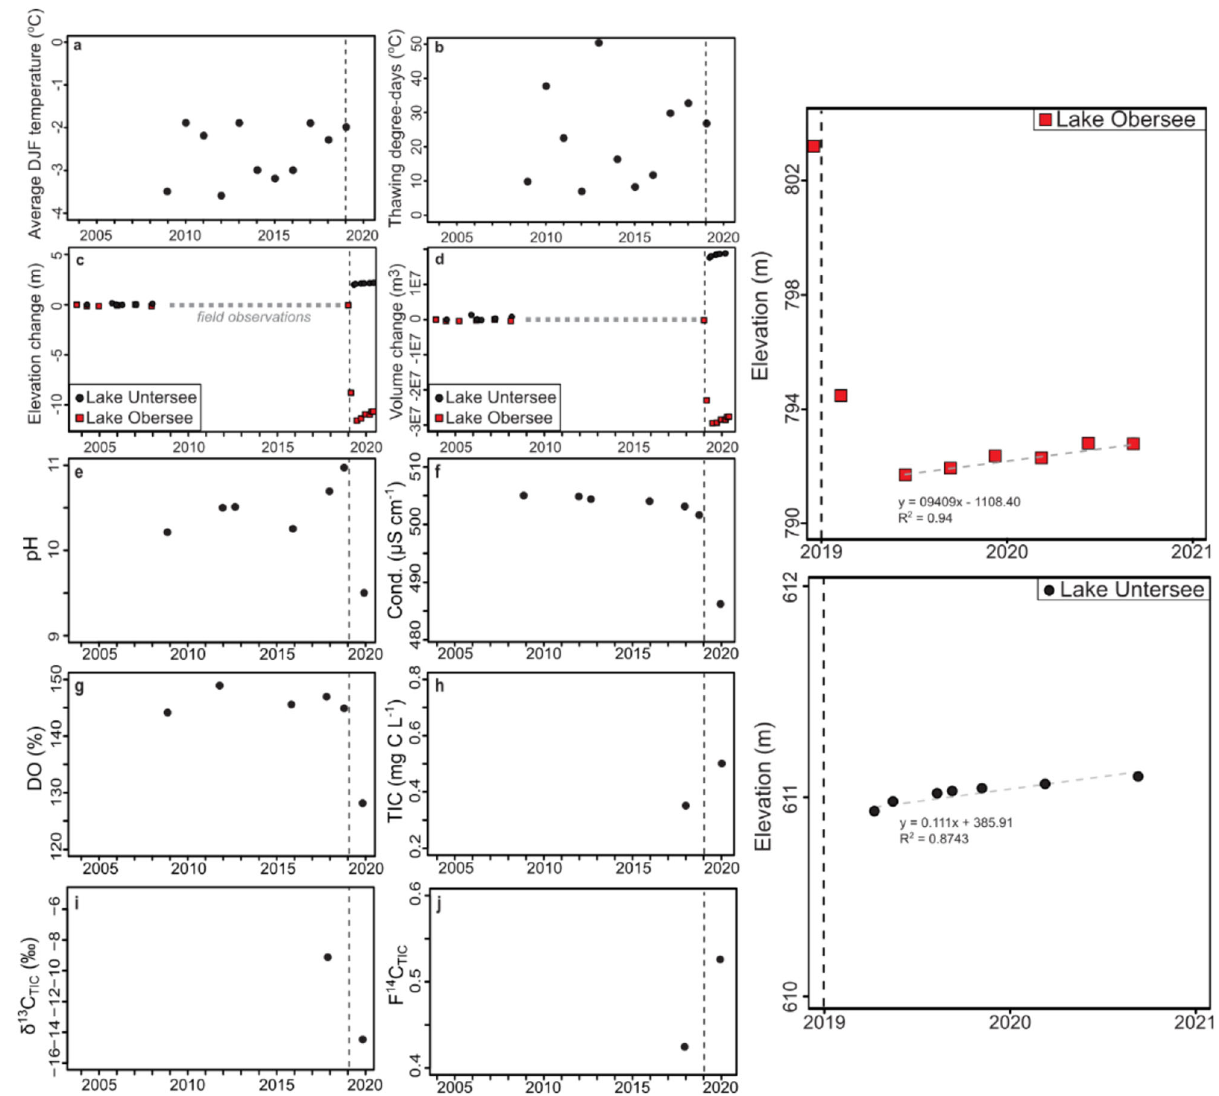
Fig. 3 2004 – 2020 Variations in hydrochemical parameters of Lake Untersee, Antarctica. a Average summer (December, January, and February; DJF) air temperature (°C) at Lake Untersee. b Thawing degree days at Lake Untersee (°C). c , d Changes in elevation (m) and volume (m 3 ) for lakes Untersee and Obersee (elevation data from ICESat and ICESat-2). e – j Mean values of pH, conductivity ( µ S/cm − 1 ), dissolved oxygen (DO%), total inorganic carbon (TIC; mg C L − 1 ), δ 13 C TIC ( ‰ ), and F 14 C TIC in the oxic water column of Lake Untersee. The dashed vertical line represents the timing of the 2019 glacial lake outburst fl ood. The scatter plots on the right side of the fi gure show elevation (m) data for Lake Untersee and Lake Obersee after the 2019 GLOF